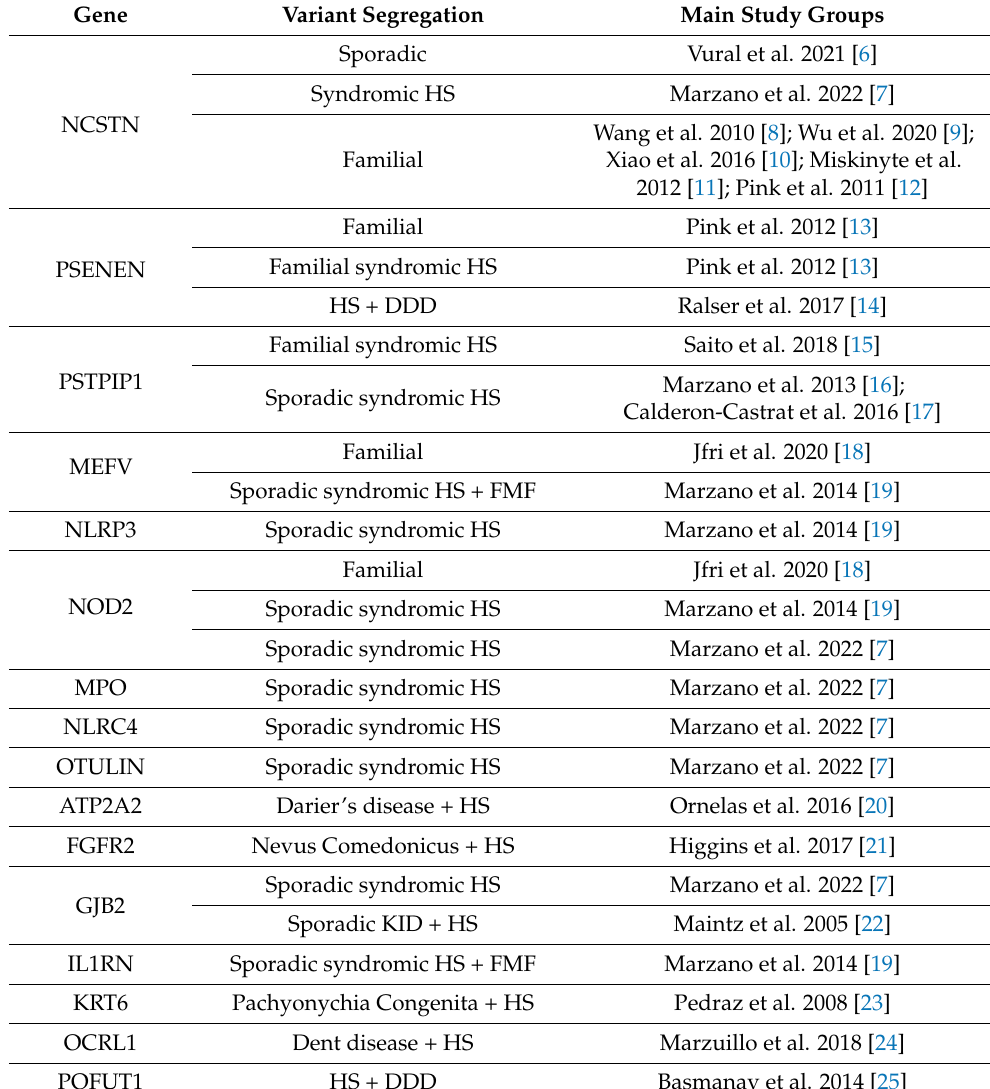
Table 1. Summary of genetic changes involved in all forms of